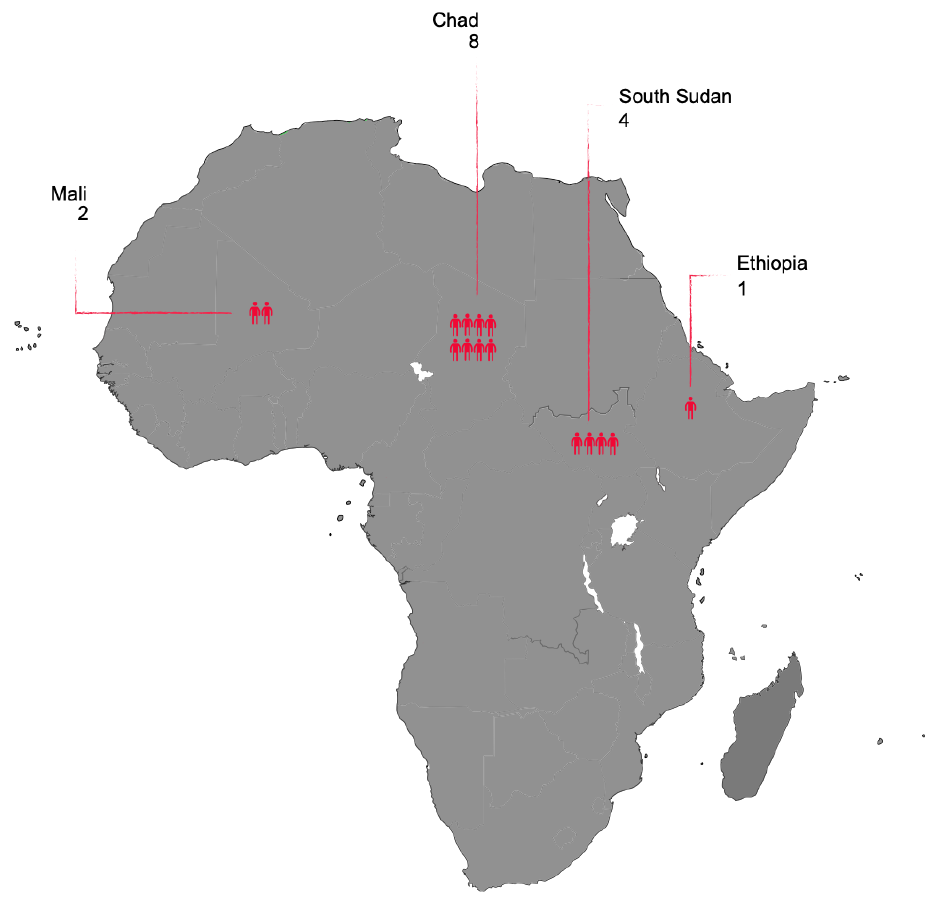
Figure 1. GWD human cases in